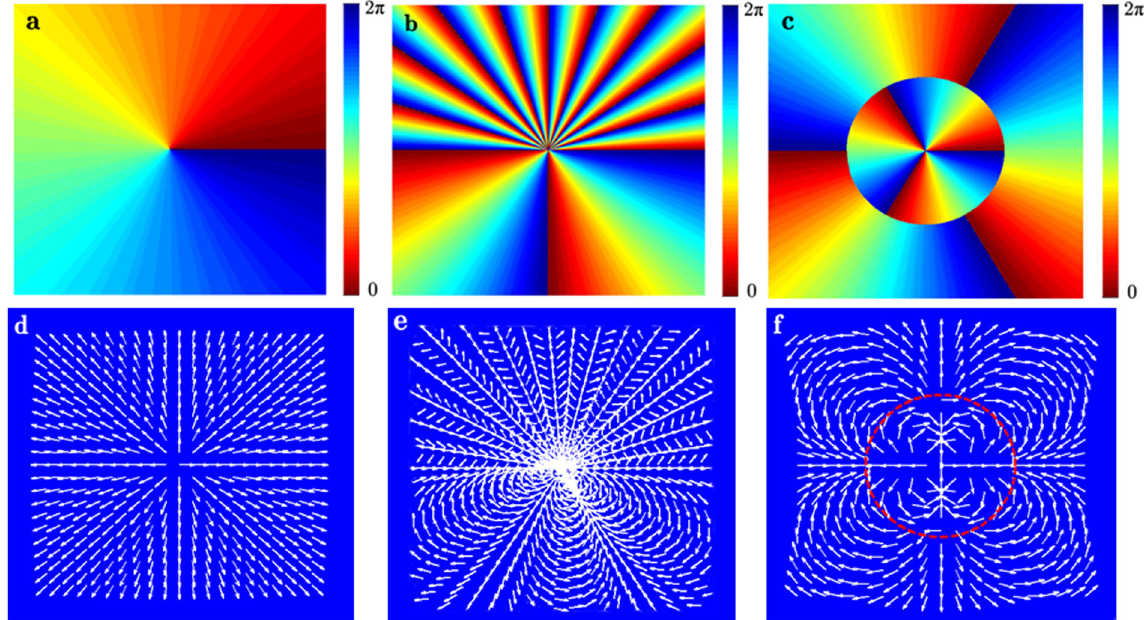
! Þ Fig. 1 Illustrations of the α ð r functions that describe the distributions of the optical axis. The corresponding expressions of α ð r = 0.5 φ , b α ( r , φ ) = 2 φ · H ( φ − π ) H (2 π − φ )+10 φ · H ( φ ) H ( π − φ ), and c α ( r , φ ) = 1.5 φ +0.5 π · H ( r − r tailored correspondingly to form different effective magnetic fi elds ( d – f ), which drive the pseudospin to present respective PSHE